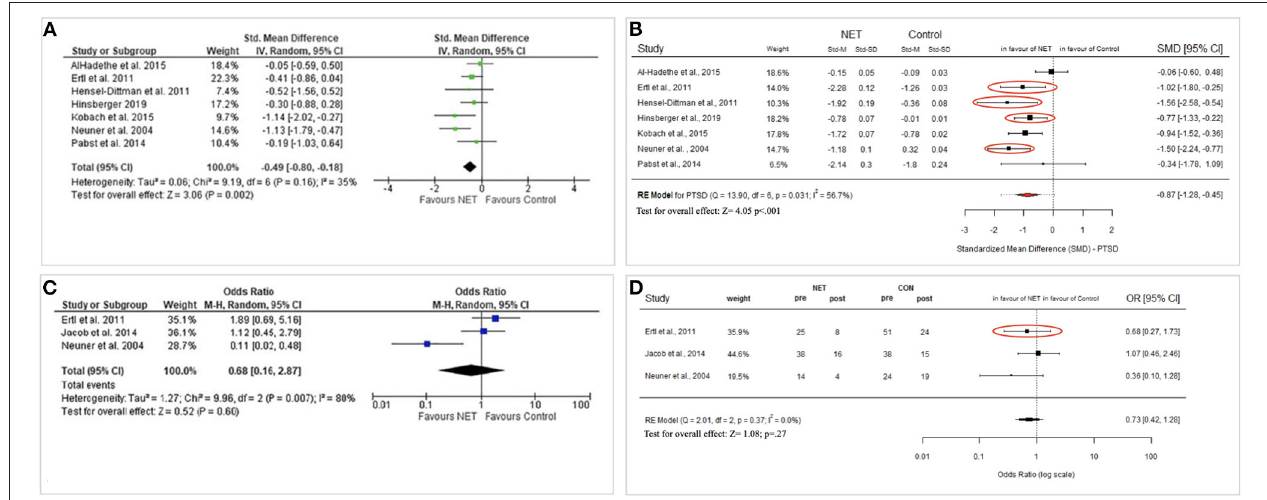
FIGURE 1 | (A) Symptom severity of PTSD (longterm) taken from Raghuraman et al. (2021, Figure B10). (B) Reconstructed data for symptom severity of PTSD (longterm). (C) Diagnosis of PTSD (longterm) taken from Raghuraman et al. (2021, Figure B7). (D) Reconstructed data for diagnosis of PTSD (longterm). Red circles indicate differences regarding the reconstructed